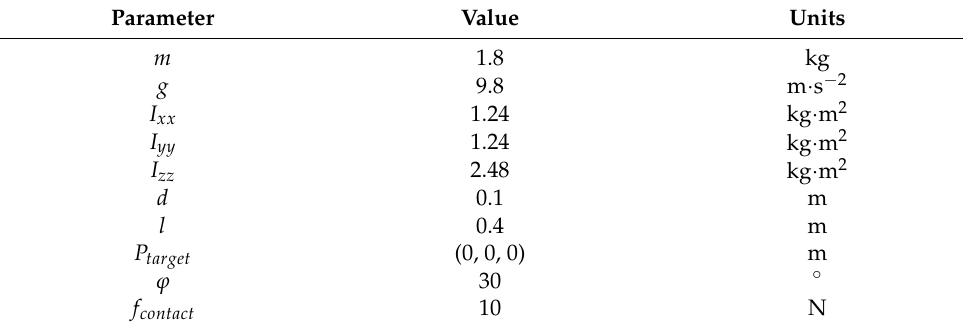
Table 1. Parameters of the aerial manipulator simulation.